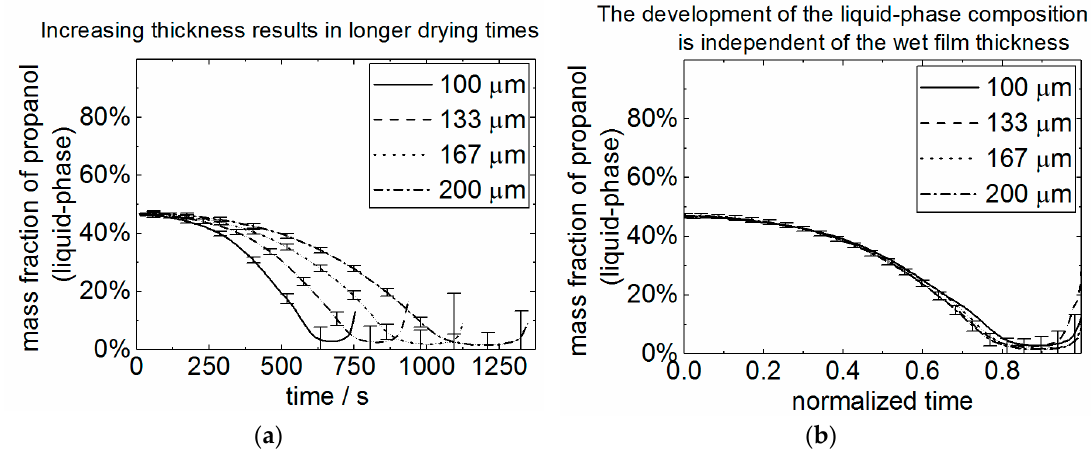
Figure 5. The mass fraction of propanol in the liquid phase of the 43 wt.% propanol-containing dispersion as a function of the drying time ( a ) and the normalized drying time ( b ) at difference wet layer thicknesses.